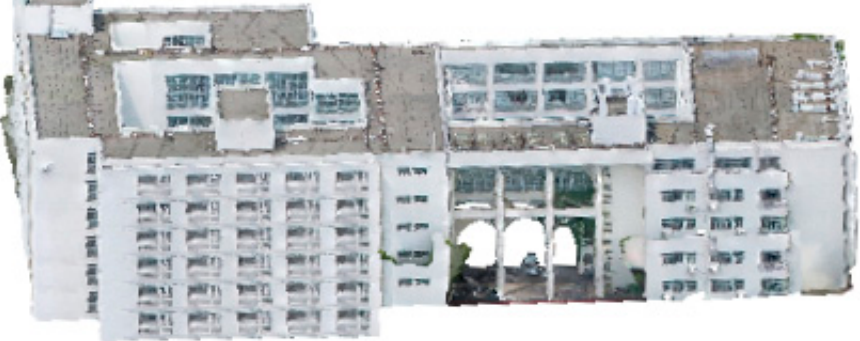
Figure 17. Filled results of building A by the proposed method.